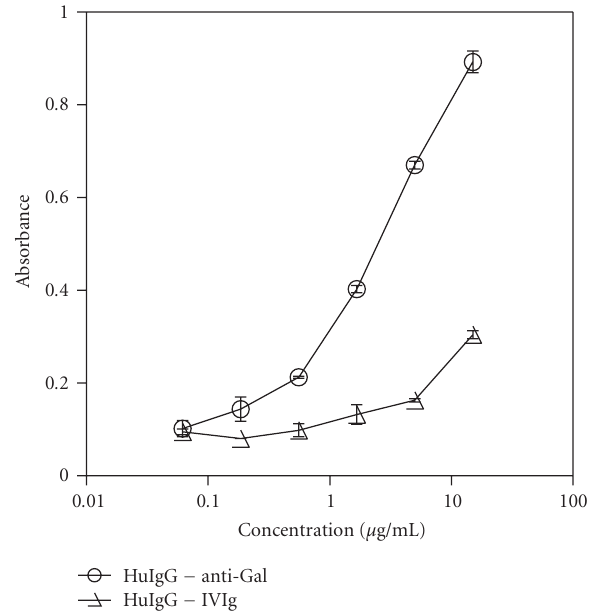
Figure 1: A. ELISA plates were coated with blood type B antigen and reactivity of Gal purified human antibodies detected. Human IVIg was used as